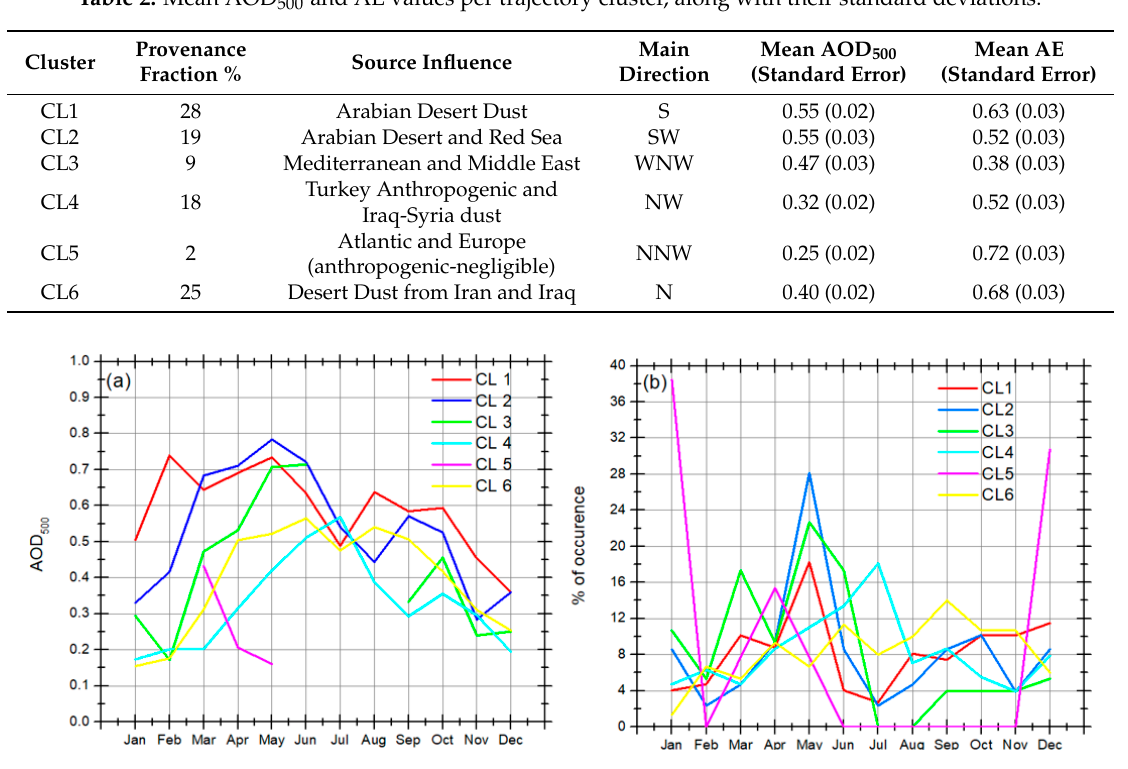
Table 2. Mean AOD 500 and AE values per trajectory cluster, along with their standard deviations.